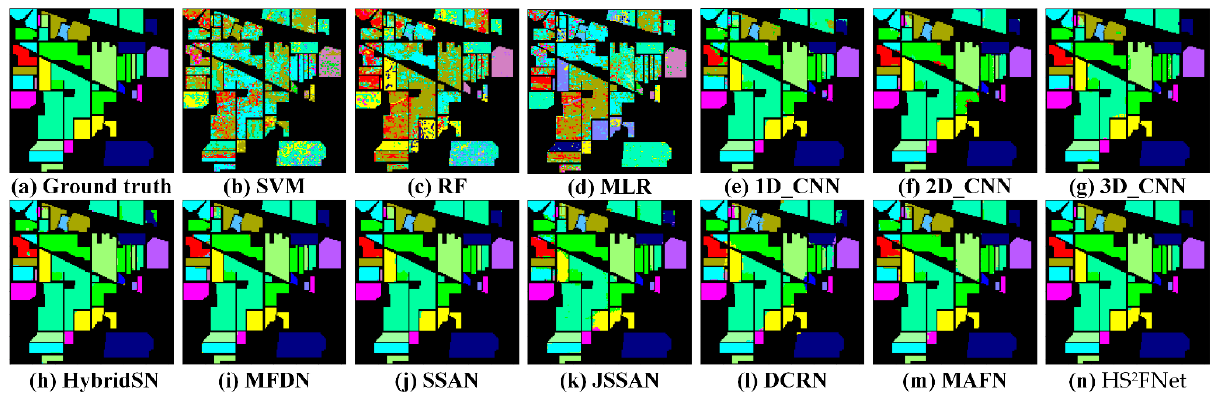
Remote Sens. 2022 , 14 , x FOR PEER REVIEW Figure 11. The visual comparisons of the state-of-the-art models and our network on KSC dataset.